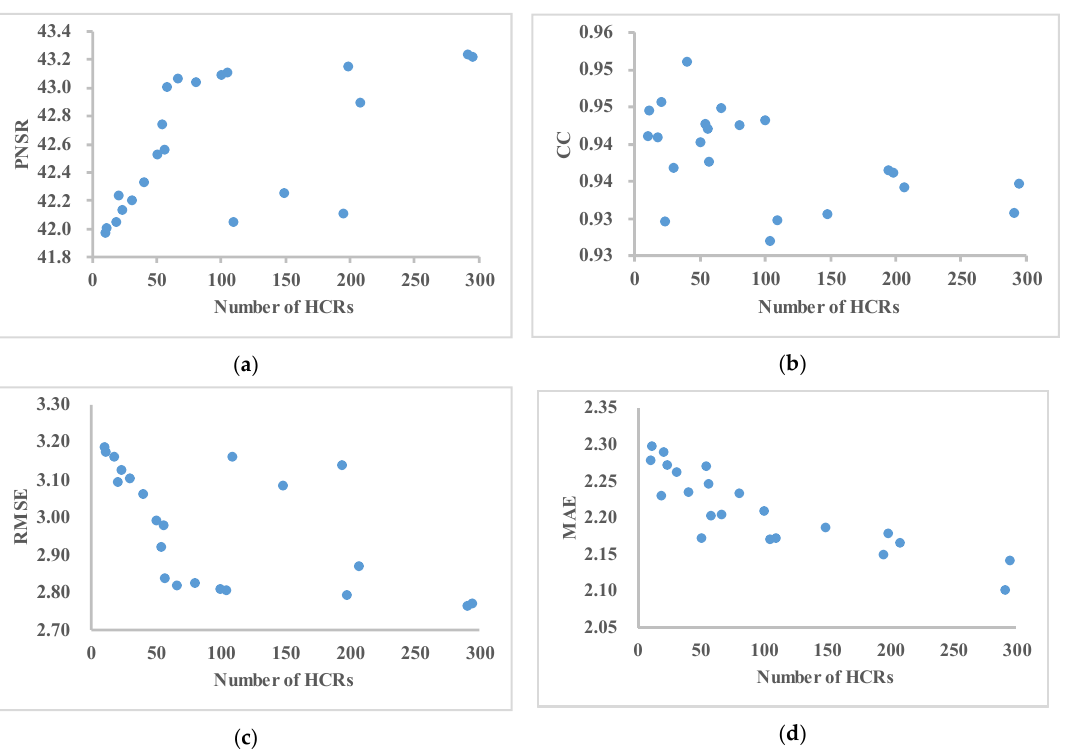
Figure 8. Comparison of model fusion results based on different numbers of HCRs. ( a ) PNSR; ( b ) CC; ( c ) RMSE; ( d ) MAE. Each point is the median value of 56 predictions (about 2027671 pixels for each prediction) across 6 predicted dates (from 1 November 2000 to 7 November 2002).